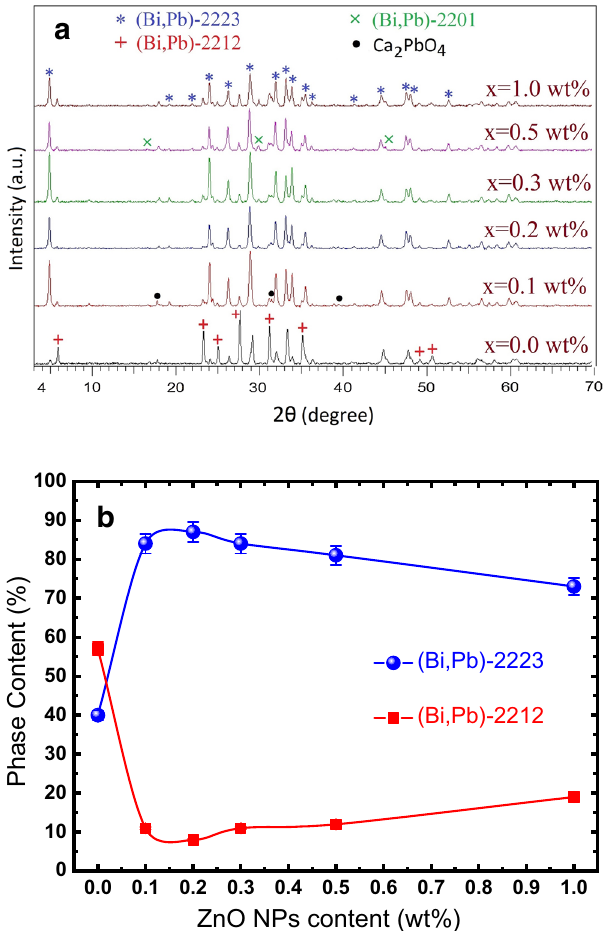
Figure 1. ( a ) XRD patterns of the sintered (Bi,Pb)-2223/(ZnO NPs)x superconducting composites with x = 0.0, 0.1, 0.2, 0.3, 0.5 and 1.0 wt%. ( b ) Variations of the (Bi, Pb)-2223 and (Bi, Pb)-2212 phases volume fractions as a function of the ZnO NPs content for sintered composites. The solid lines are to guide the